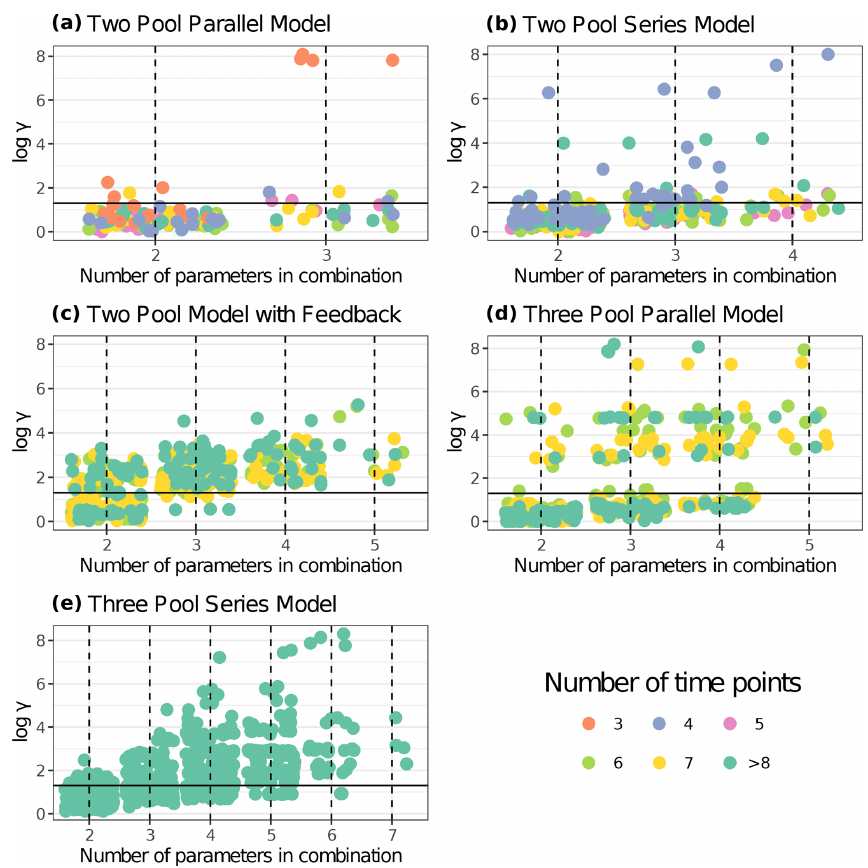
Figure 5. Collinearity index ( γ ) comparison for different model structures using entries from aridec . γ values were log 10 transformed, and horizontal lines at log 10 (20) denote the maximum value of γ for a model to be considered identifiable. Infinite γ values were not plotted. Each panel shows data for a different model structure. The number of entries from the database used for each model structure is reported in Table 3. Each point represents γ for a model structure fitted for a specific dataset with different parameter combinations. The color scale for data points shows the number of data points in each dataset (i.e., the number of sampling dates plus the initial date). Values with > 8 time points were grouped for easier interpretation. The number of model variants fitted for each model structure and database entry were n = 30 for the two pool parallel model with all three parameters and n = 90 with one restricted parameter (a) ; n = 25 for the two pool series model with all four parameters, n = 150 with two restricted parameters, and n = 100 with one restricted parameter (b) ; n = 15 for the two-pool model with feedback and all five parameters, n = 150 with two and three restricted parameters, and n = 75 with one restricted parameter (c) ; n = 15 for the three pool parallel model with all five parameters, n = 150 with two and three restricted parameters, and n = 75 with one restricted parameter (d) ; n = 5 for the three pool series model with all seven parameters, n = 250 with five restricted parameters, n = 300 with four restricted parameters, n = 230 with three restricted parameters, n = 115 with two restricted parameters, and n = 35 with one restricted parameter (e)